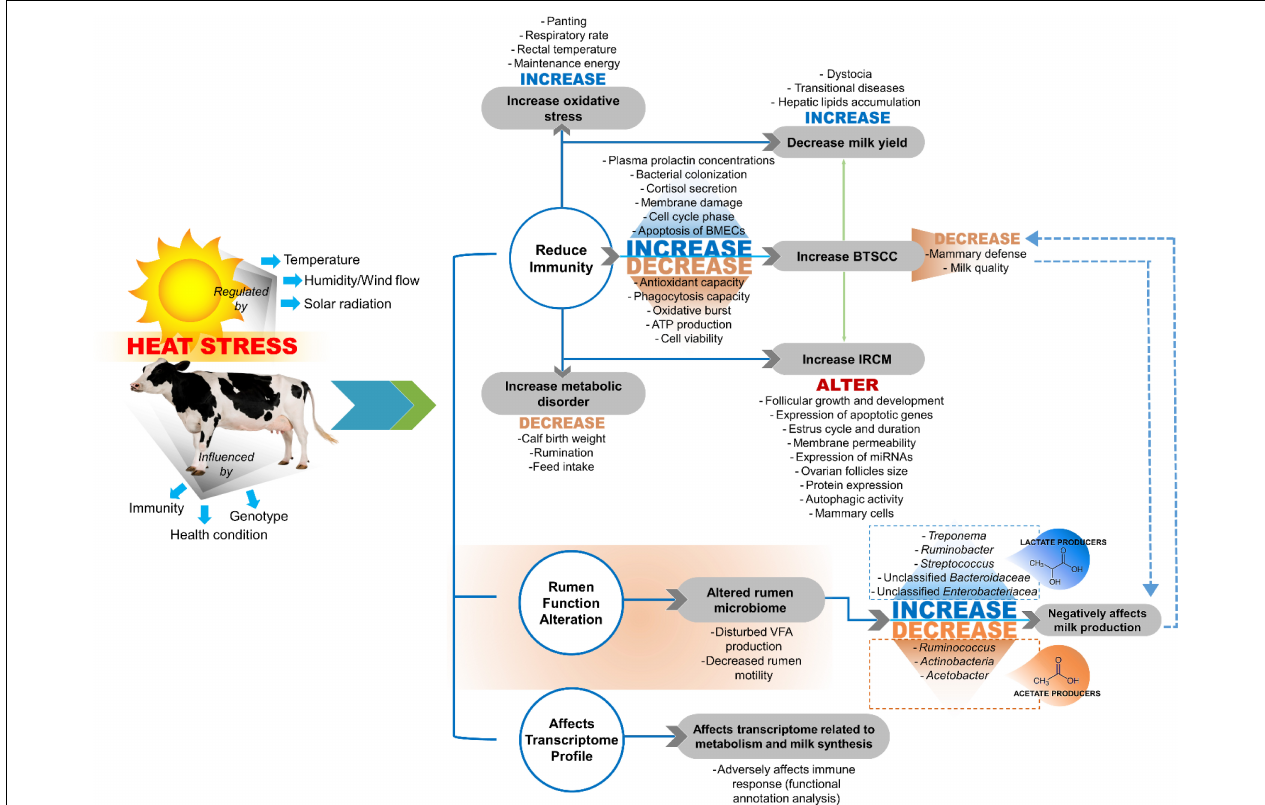
FIGURE 1 | Impact of heat stress on dairy production. BTSCC, bulk tank somatic cell count; IRCM, incidence rate of clinical mastitis (Kim et al., 2020; Rakib et al., 2020; Sammad et al.,